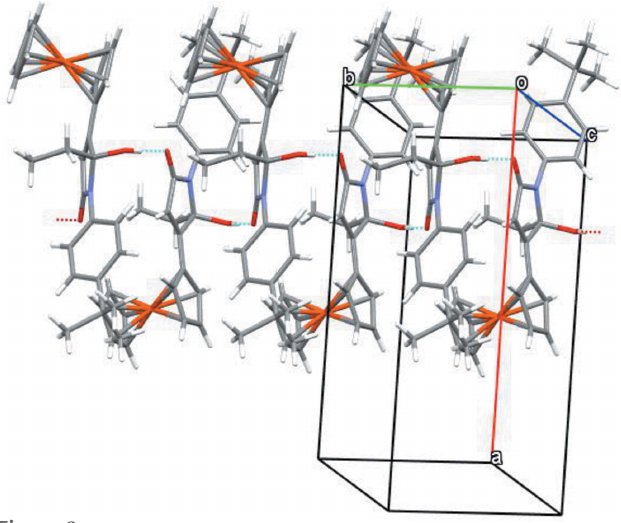
Figure 2 Infinite chain of the S -enantiomers along the b -axis.